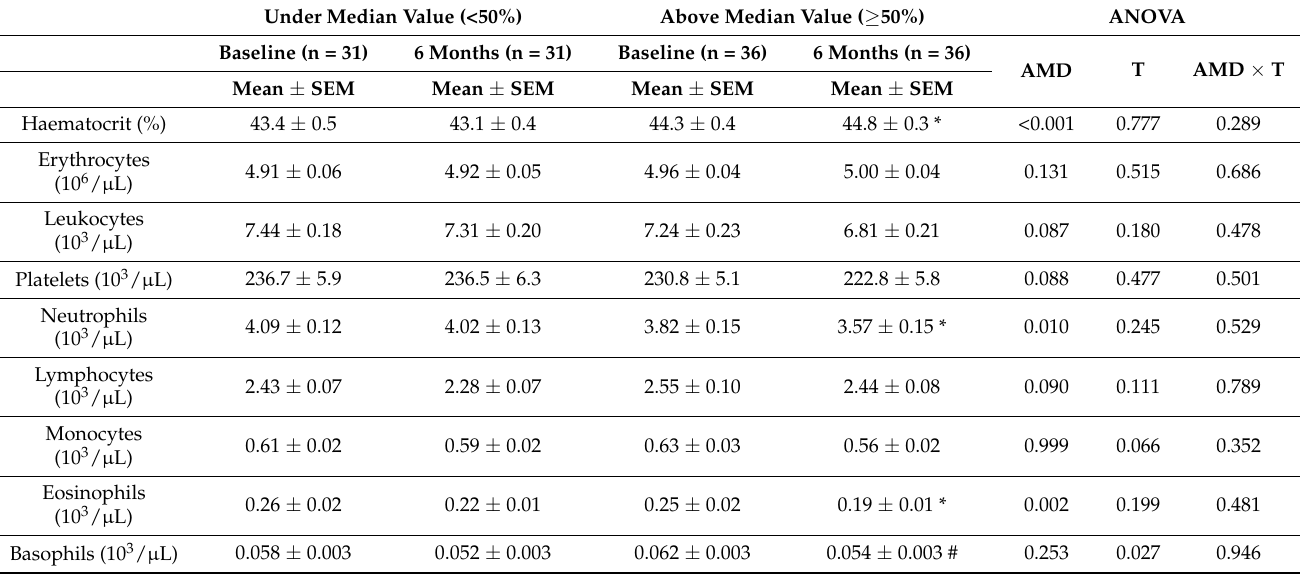
Table 4. Hemogram of participants “Baseline” and “6 months” stratified by adherence to Mediter- ranean diet (AMD).